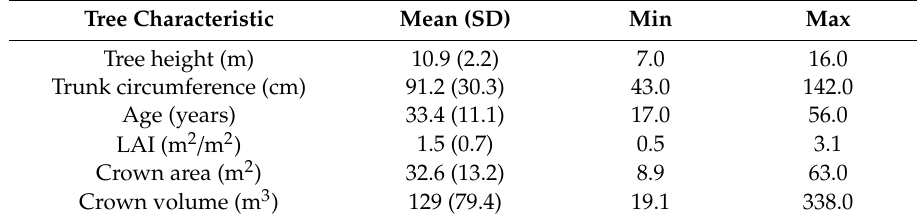
Table 2. Overview of tree characteristics with mean values, standard deviations, minima, and maxima.